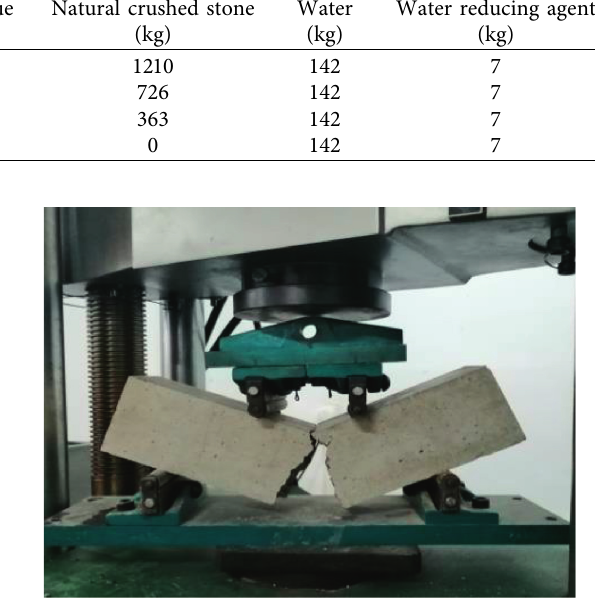
Figure 3: Flexural strength test.